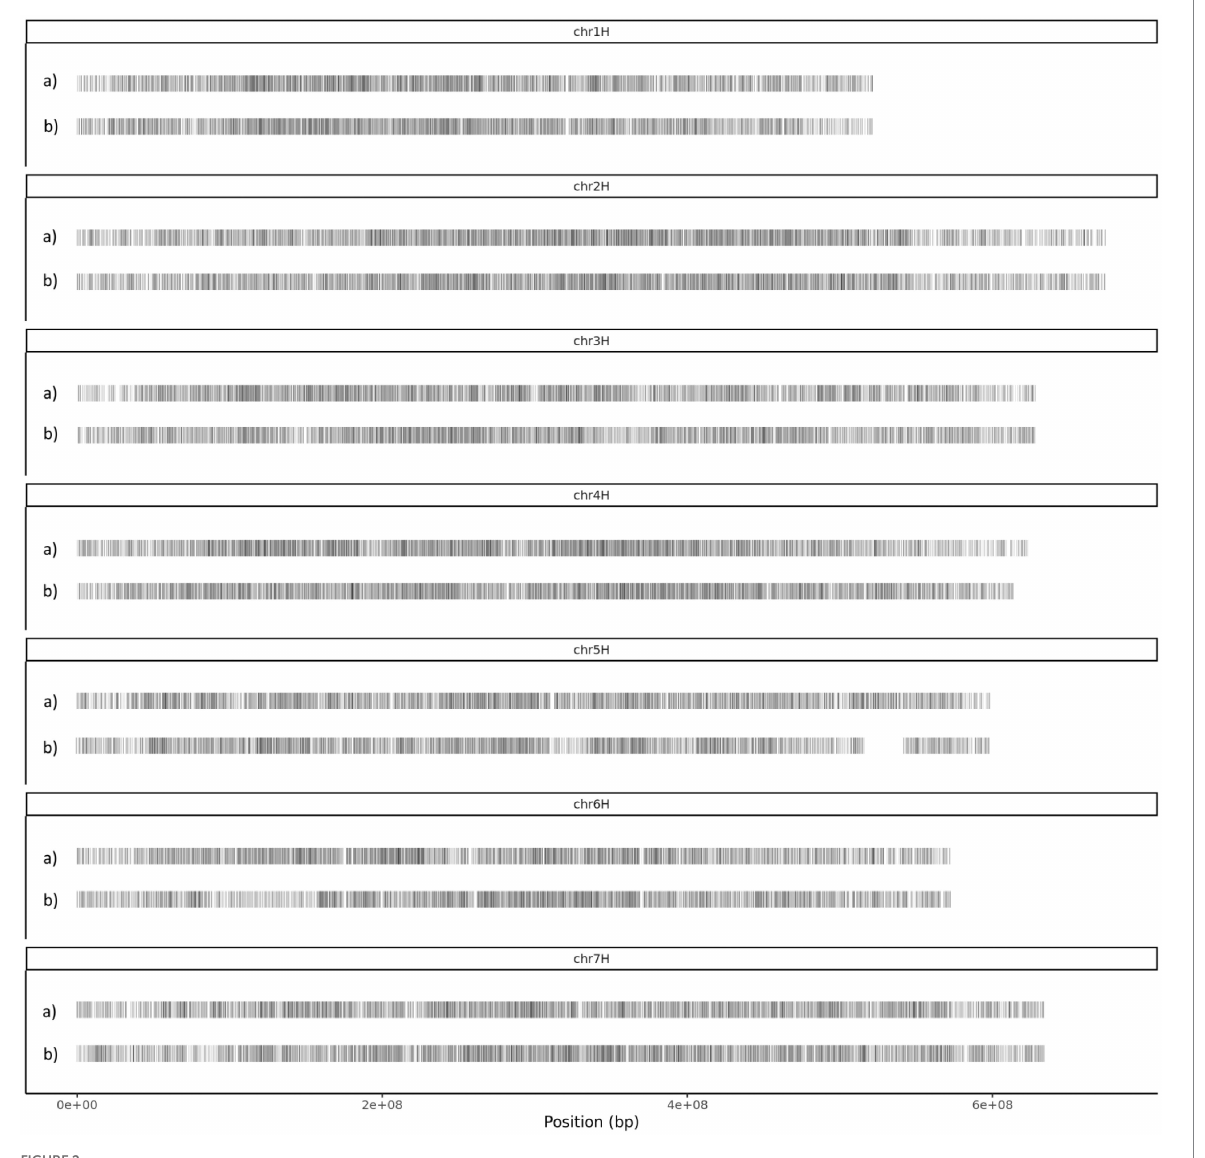
FIGURE 2 SNP distribution across the seven barley chromosomes, a) Bowman and b) BW230. The introgressed regions have been removed and can be seen as gaps on chromosome 5H and at the end of chromosome 4H.